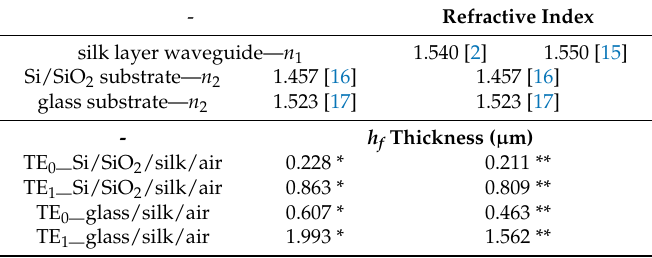
Table 1. Refractive indices used for design of the silk planar waveguides for wavelength 632.8 nm and calculation of thickness h f for supporting transverse electric (TE) 0 and TE 1 modes.